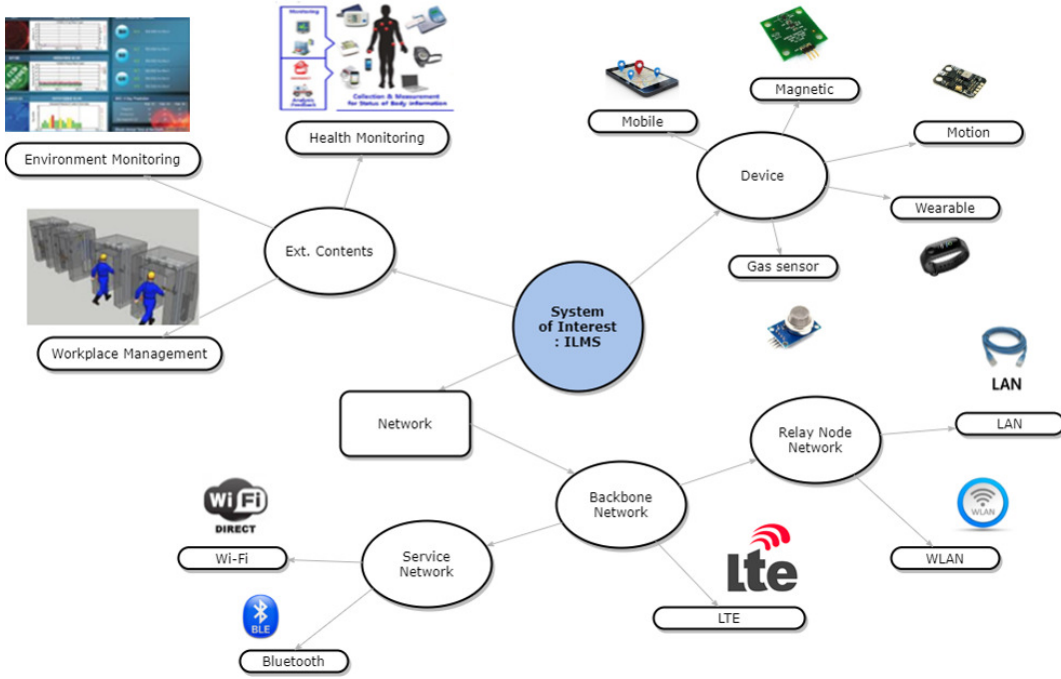
Figure 2. System context and components of the